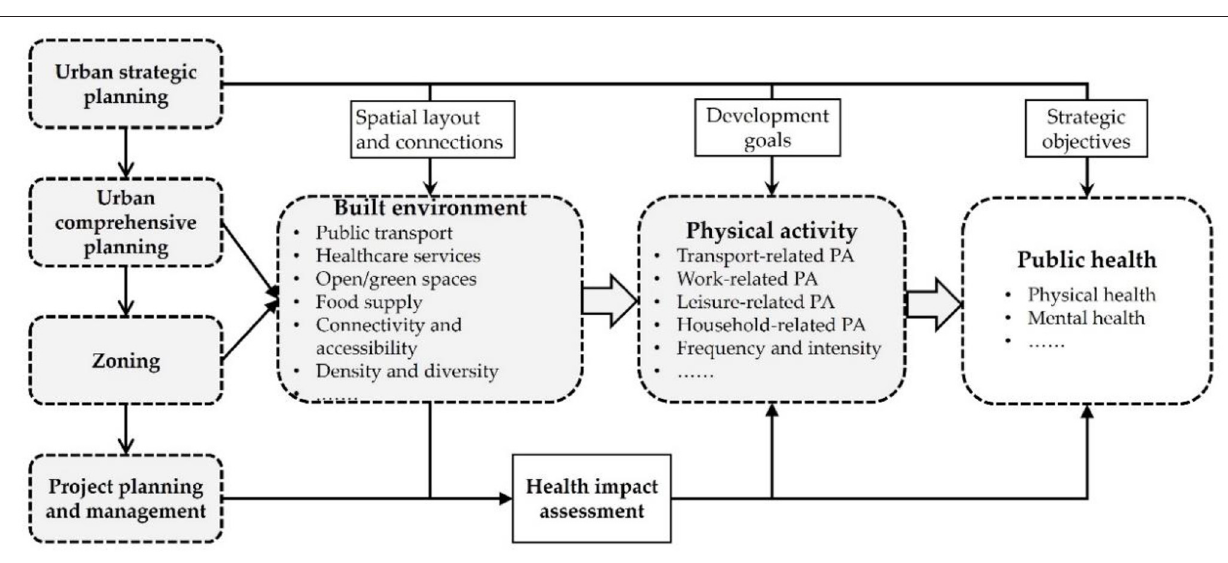
FIGURE 7 | Health intervention in multi-level spatial